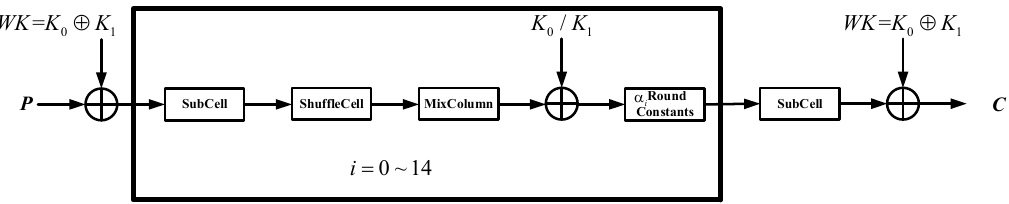
Figure 2. Overall structure of Midori ‐ 64.